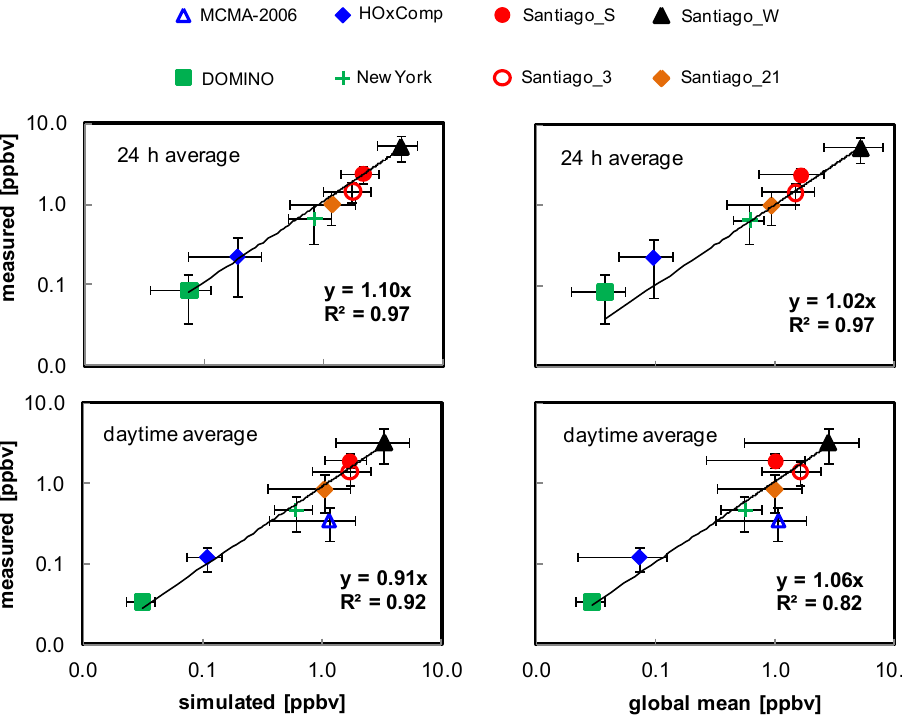
Fig. 10. Correlations between measured and calculated HONO mixing ratios for 24h (upper panel) and daytime averages (lower panel) based on the HONO/NO x dependency (simulated, left panel, see text for details) and that calculated using the mean HONO/NO x ratio of 0.02 (global mean, right panel) for the different measurement campaigns. Error bars represent 1 σ of the mean.